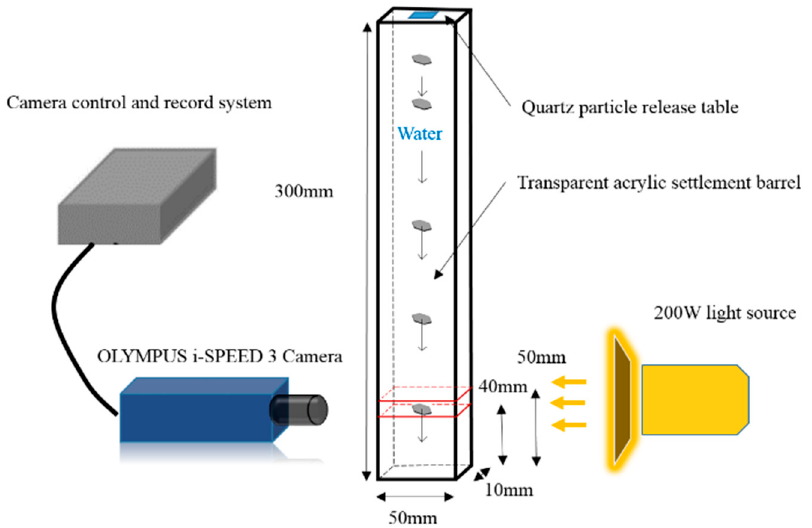
Figure 4. HD sedimentation photography